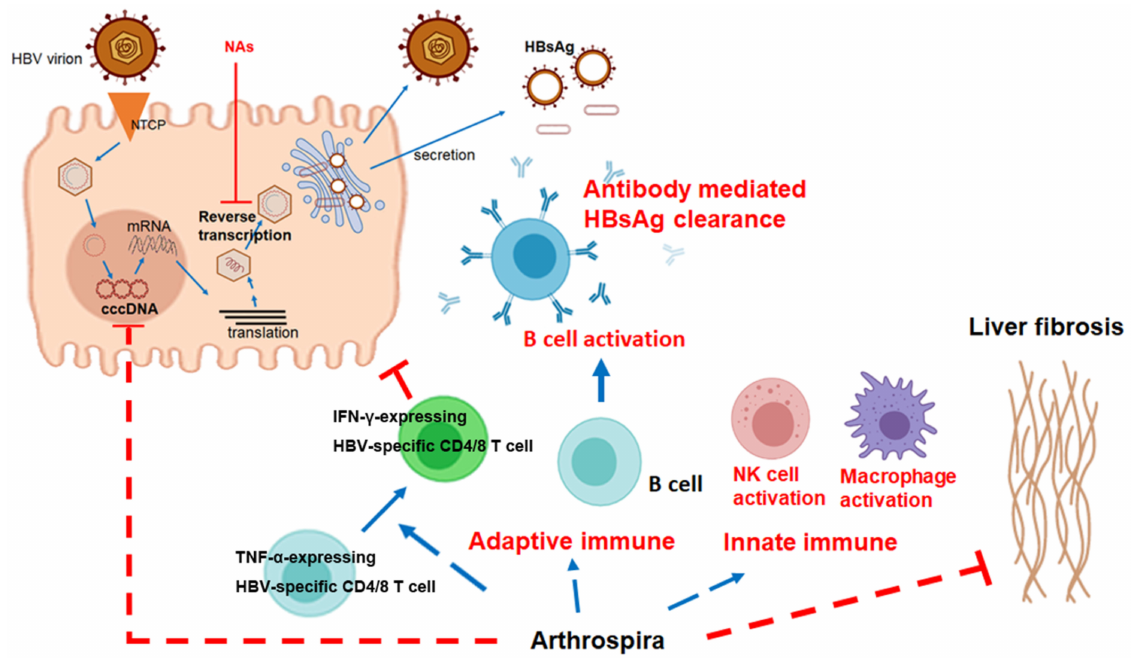
Figure 6. The possible mechanism of HBV reduction by Arthrospira and nucleos(t)ide analogues. First, the antiviral treatment with NAs suppresses HBV reverse transcription and DNA polymerase. Second, Arthrospira modulates the TNF- α /IFN- γ profile to trigger the differentiation of TNF- α - expressing HBV-specific CD4 and CD8 T cells into IFN- γ -expressing CD4 and CD8 T cells. Also, Arthrospira enhances the antibody-mediated reduction and clearance of HBsAg extracellularly. In addition, Arthrospira may have the potential to target the epigenetic regulation of HBV covalently closed circular DNA (cccDNA) intracellularly. Arthrospira also enhances innate immune response and attenuates HBV-induced liver fibrosis. NTCP, sodium-taurocholate co-transporting polypeptide; NAs, nucleos(t)ide analogues. Created with Biorender.com (accessed on 17 May